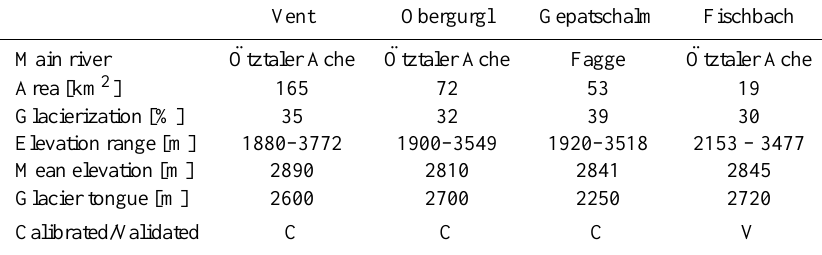
Table 1. Main characteristics of gauged glacierized catchments (C=Calibrated, V=Validated, both for discharge and snow).